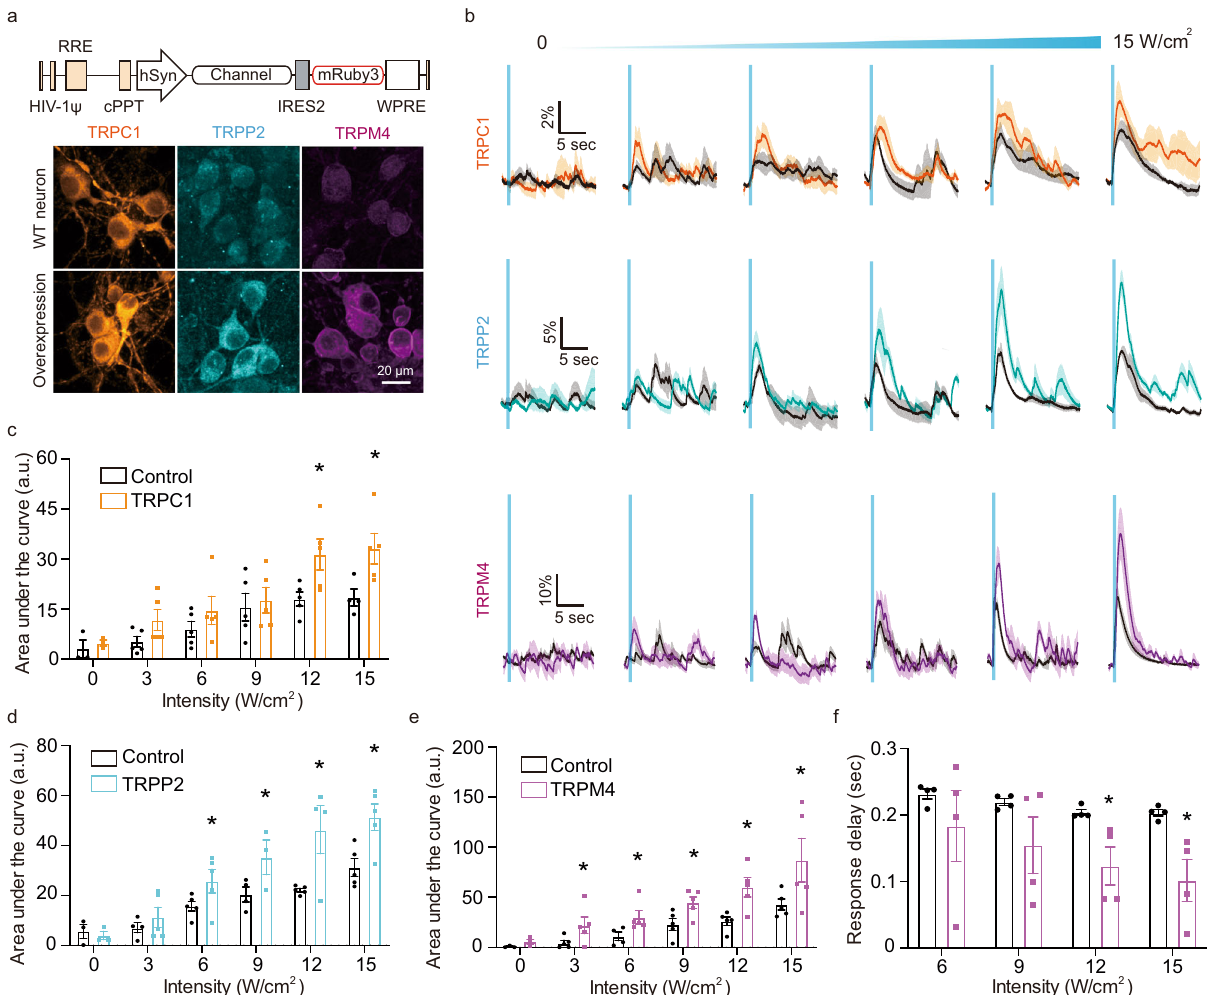
Fig. 7 Neuronal response to ultrasound is enhanced by overexpression of mechanosensitive and ampli fi er channels. a Schematic of genetic constructs for overexpressing TRPC1, TRPP2, and TRPM4 and representative immunostaining images for the channels with and without overexpression. b Calcium responses from wild type neurons and overexpressing neurons as function of ultrasound intensity and quanti fi cation of area under the curve for c TRPC1 ( n = 5 independent experiments each, Unpaired T -test, two-tailed, p = 0.0316 (12 W/cm 2 ), p = 0.0369 (15 W/cm 2 )), d TRPP2 ( n = 5 independent experiments each, Unpaired T -test, two-tailed, p = 0.0855 (6 W/cm 2 ), p = 0.0795 (9 W/cm 2 ), p = 0.0105 (12 W/cm 2 ), p = 0.0127 (15 W/cm 2 )), and e TRPM4 ( n = 5 independent experiments each, Unpaired t -test, two-tailed, p = 0.0815 (3 W/cm 2 ), p = 0.0578 (6 W/cm 2 ), p = 0.0317 (9 W/cm 2 ), p = 0.0114 (12 W/cm 2 ), p = 0.0841 (15 W/cm 2 )). f Comparison of response delay of calcium response between wild type and TRPM4-overexpressing neurons ( n = 5 independent experiments each, Unpaired T -test, two-tailed, p = 0.0321 (12 W/cm 2 ), p = 0.0442 (15 W/cm 2 )). Mean trace is solid and SEM is shaded. Bar graph values represent mean ±